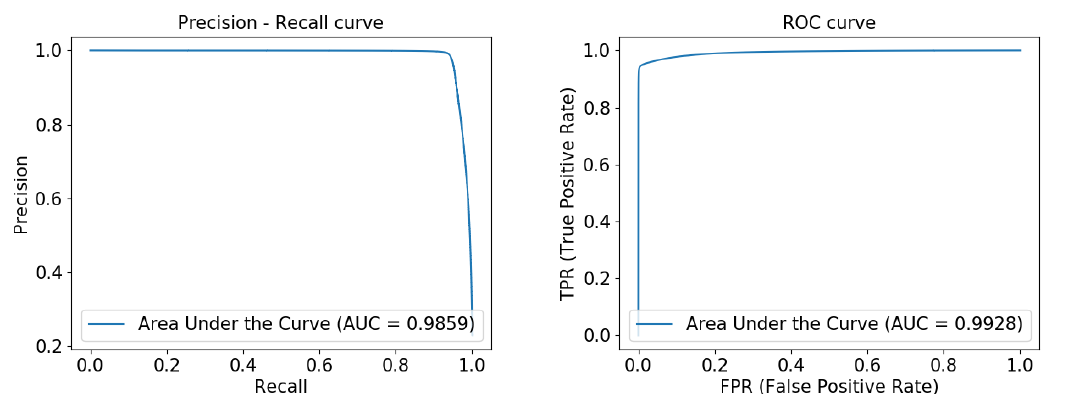
Figure 9. From left to right, the Precision-recall curve and ROC curve experimentally obtained on the CORO data set by